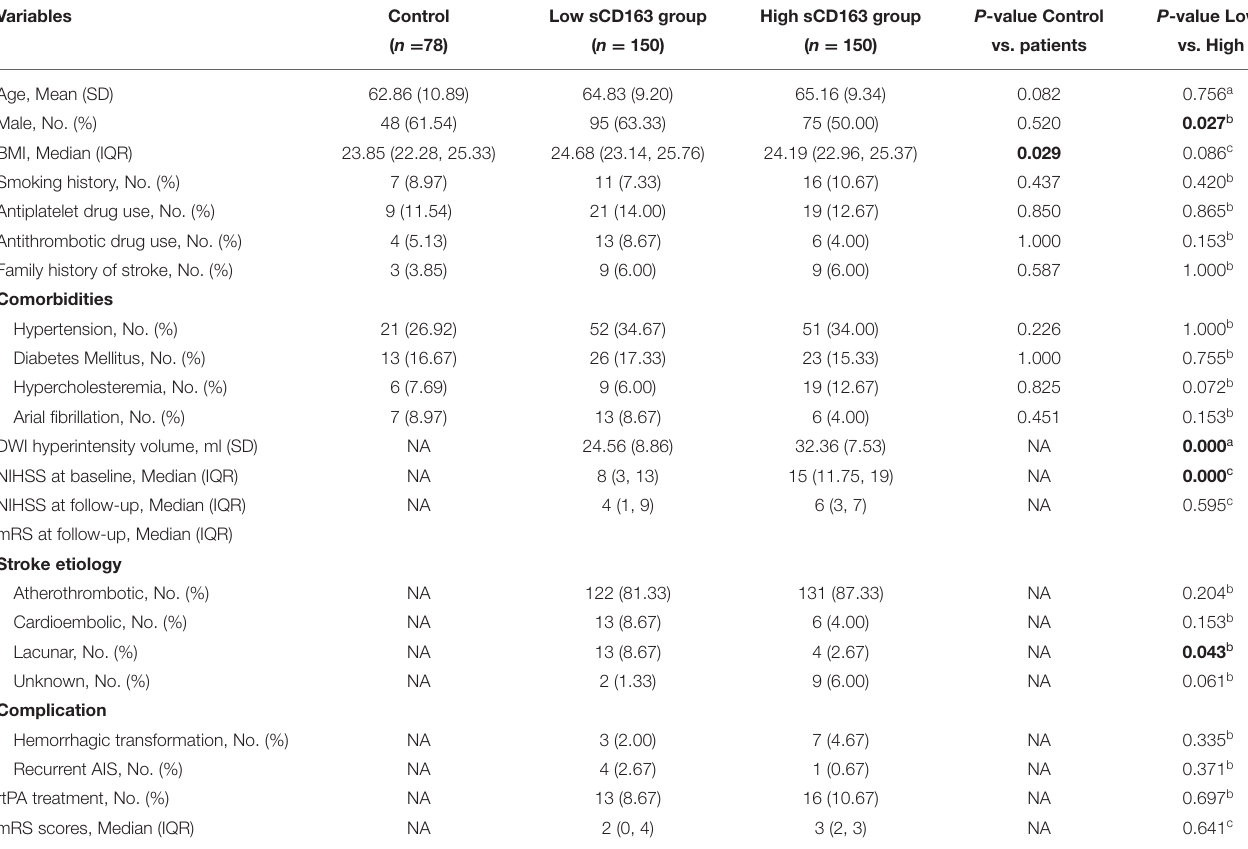
TABLE 1 | Demographic data of subjects. Variables Control High sCD163 group